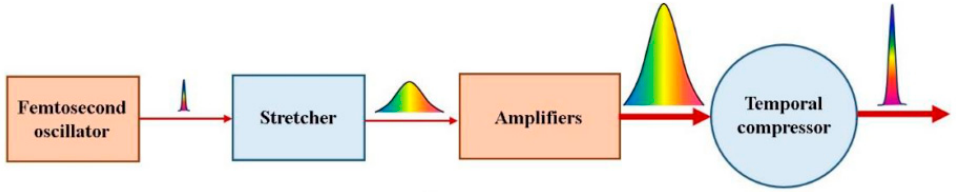
Figure 4. The principle of chirped pulse amplification.